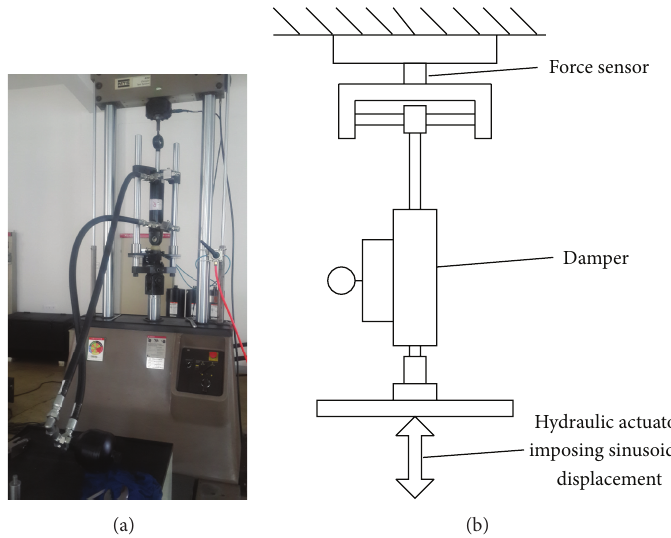
Figure 3: Test setup: (a) photo of the test rig; (b) damper sensors and the hydraulic actuator.